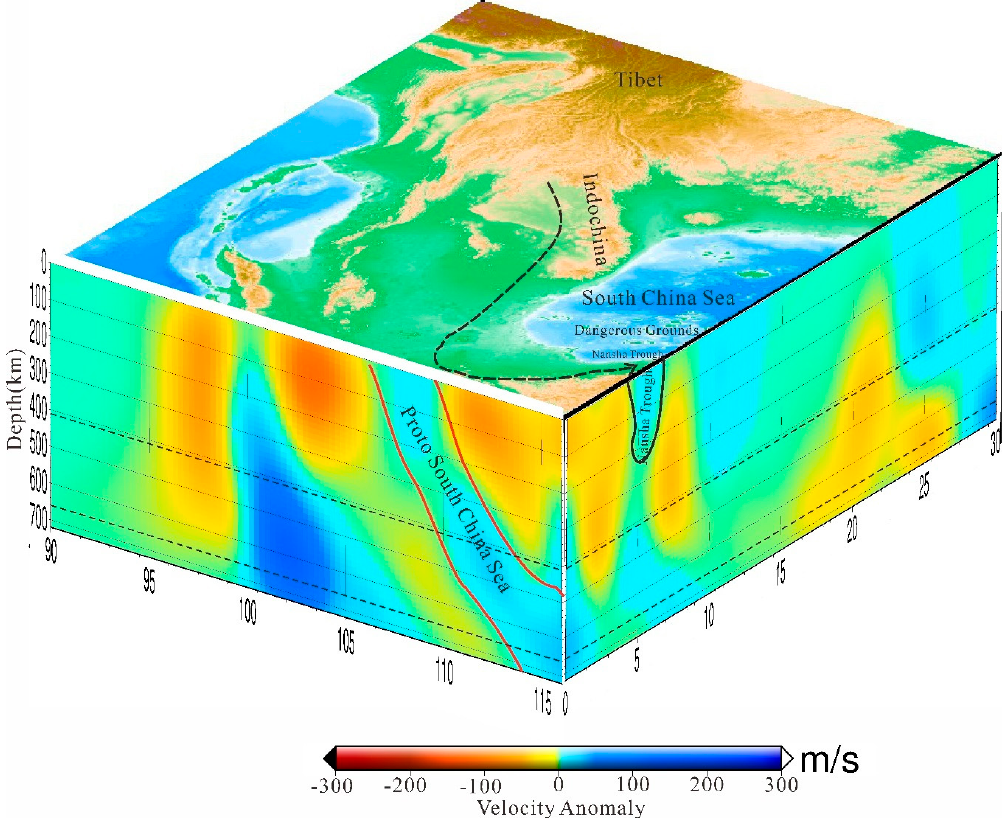
Figure 14. Cartoon diagram denotes the suture location of the PSCS.